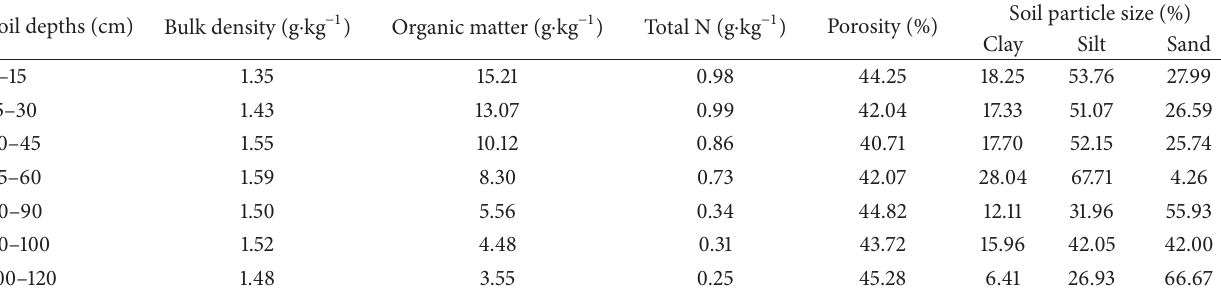
Table 1: Properties of the anthropogenic-alluvial soil in the study site.